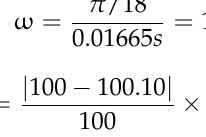
Figure 4. The 100 rpm oscilloscope waveform.